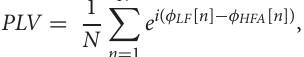
FIGURE 2 | represents the time evolution of a single channel, with channels in the left hemisphere shown above the white line and channels in the right below. Light shades of blue represent pre-recruitment levels of phase-locked high gamma, high gamma amplitude or low-frequency line length, at each time and channel, respectively, with progressively darker shades representing increasing levels up to the threshold of 3.05 standard deviations above the pre-recruitment mean. Time points at which individual channels first surpass the threshold value are denoted by yellow triangles. Line length shows a trend toward left-sided onset pre-CC, however the seizures lateralize to the right post-CC. High gamma measures trend toward right-sided onset pre-CC, especially high-gamma amplitude, and also reach the recruitment threshold earlier in the course of the seizure post-CC than low-frequency line length does. Pre-CC, pre-corpus callosotomy; Post-CC, post-corpus